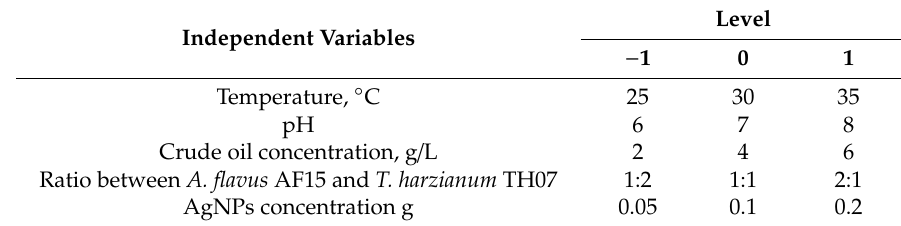
Table 1. Levels of variables for the experimental